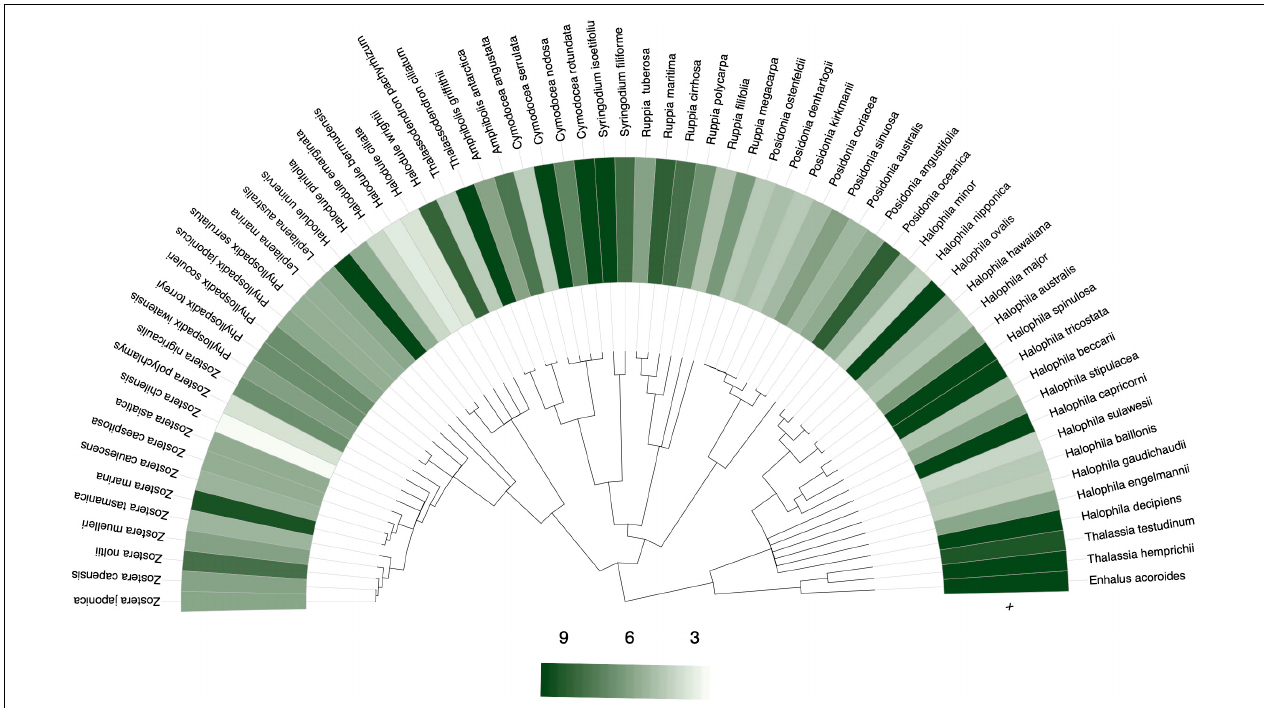
FIGURE 6 | Phylogenetic bias in seagrass sampling. Phylogenetic distribution of the number of specimens sampled per seagrass species to assess the tendency of closely related species to be similarly collected. No statistically significant phylogenetic signals were detected, although there was slight favoring for sampling of the Thalassia, Enhalus, and Halophila genera over other seagrass genera. Source data are provided as a Source Data